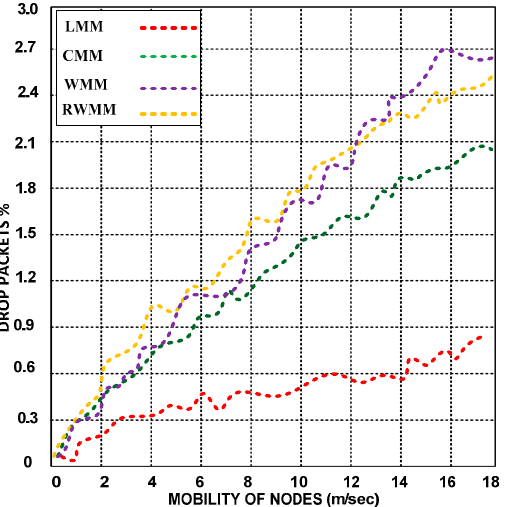
Figure 10. Packet drop rates using the LMM, CMM, RWMM, and WMM at different velocities. (D) Residual energy